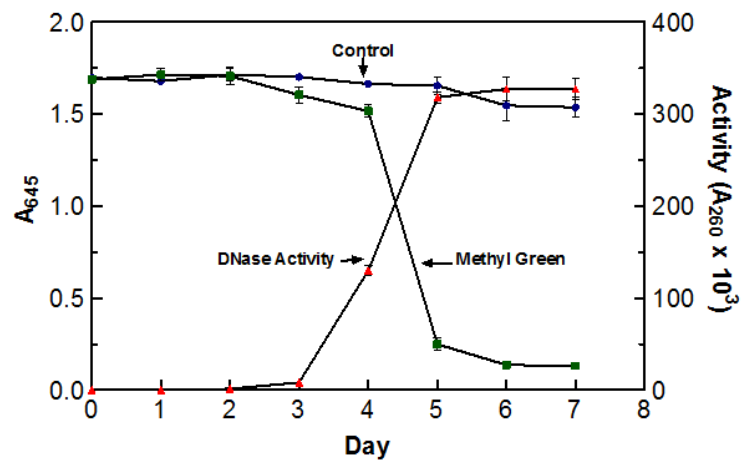
Figure 1. The effect of temperature and DNase activity on the decoloration of the DYpSs liquid media. Based on the results from the control flask, incubation at 55 °C did not have any significant effects on the color intensity of the media. A direct relationship between an can be seen. Color intensity was increase in DNase activity and the decrease in A 645 measured at 645 nm, which is the optimal absorption wavelength of methyl green. Enzyme activity was measured using the acid soluble assay with a 60 min digestion time at 55 °C. All assays were performed in